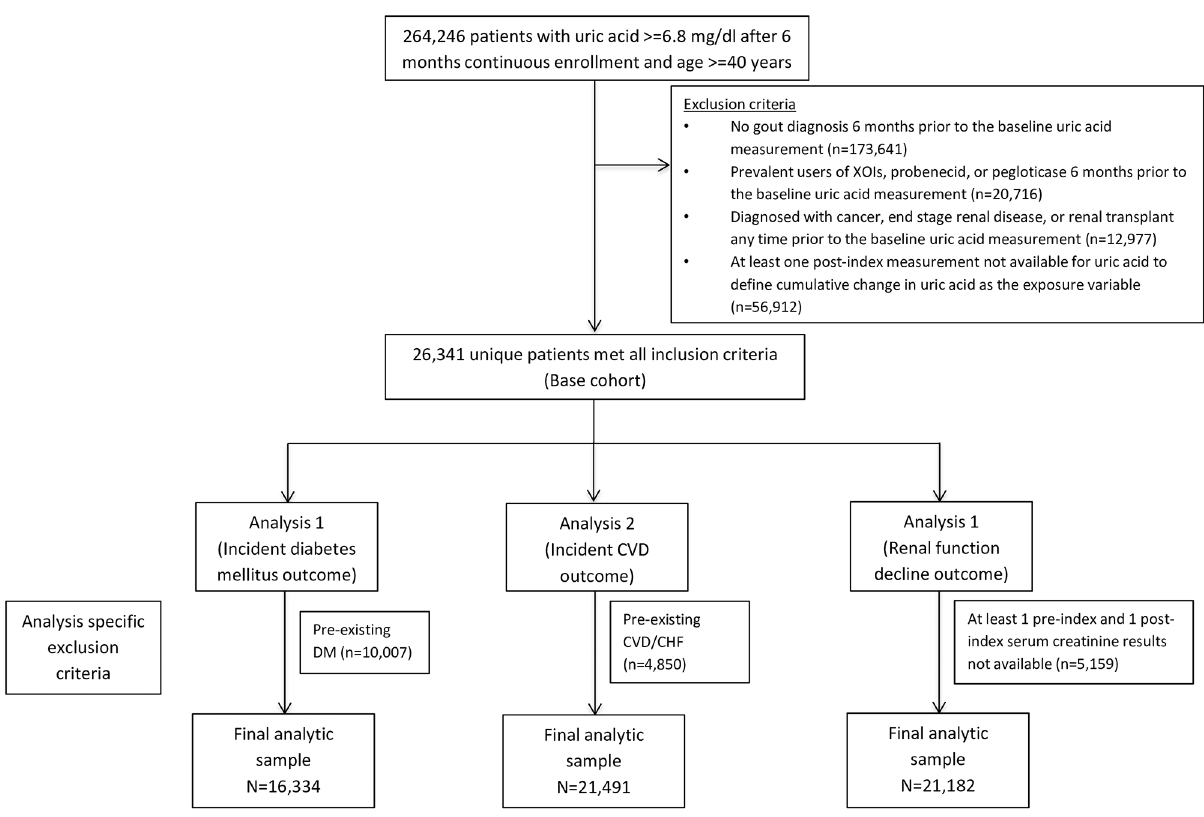
Fig 1. Cohort selection flow-chart, Clinformatics ™ Datamart 2004–2015. Abbreviations: CVD- Cardiovascular, DM- diabetes mellitus, XOI- Xanthine oxidase inhibitor.